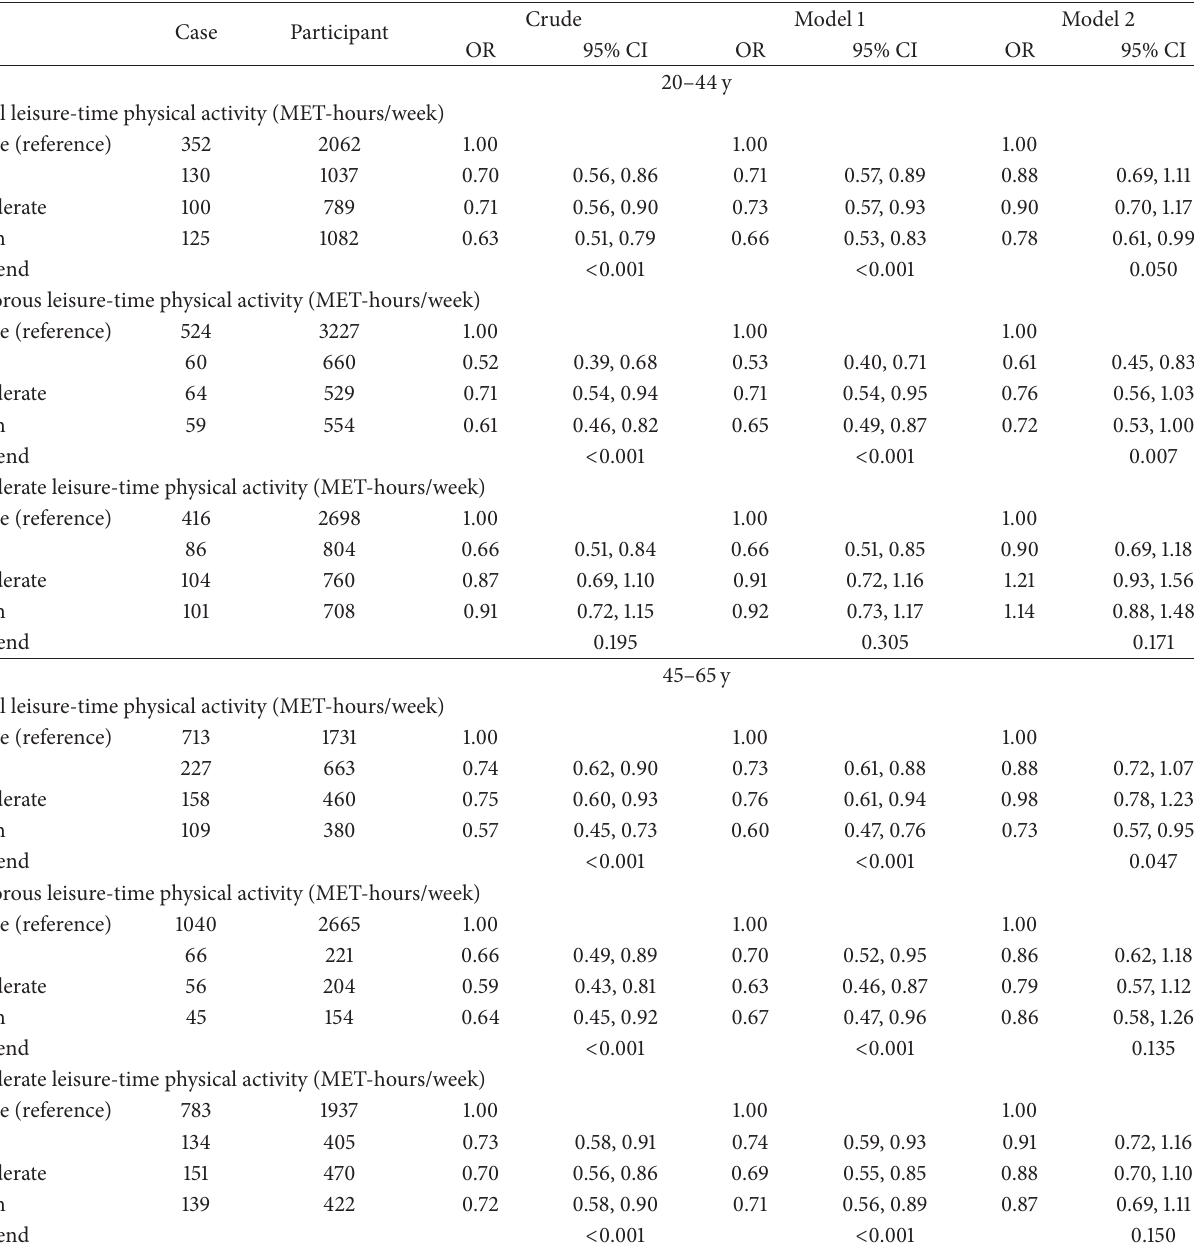
Table 3: Odds ratios of prediabetes according to category of leisure-time physical activity, stratified by age, NHANES 2007–2012, ages 20–65 y.